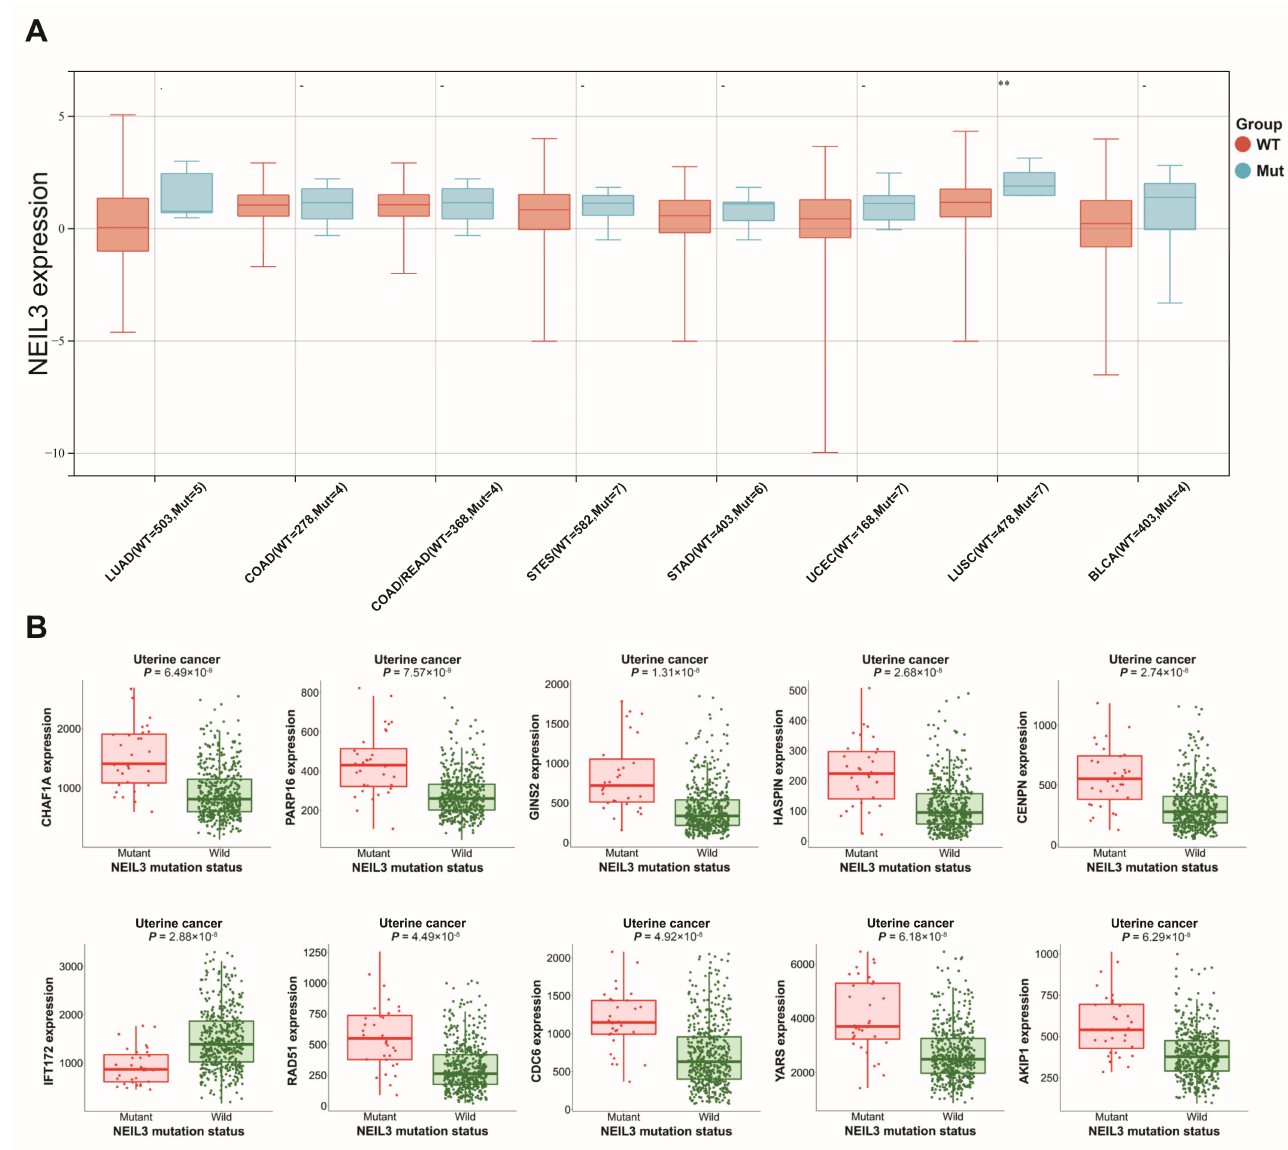
Figure 4. Prediction of NEIL3 expression and affected genes related to NEIL3 mutation. ( A ) The expression of NEIL3 between NEIL3 mutation and non-mutation groups. ( B ) Expression of the genes affected by NEIL3 mutation. ** p <